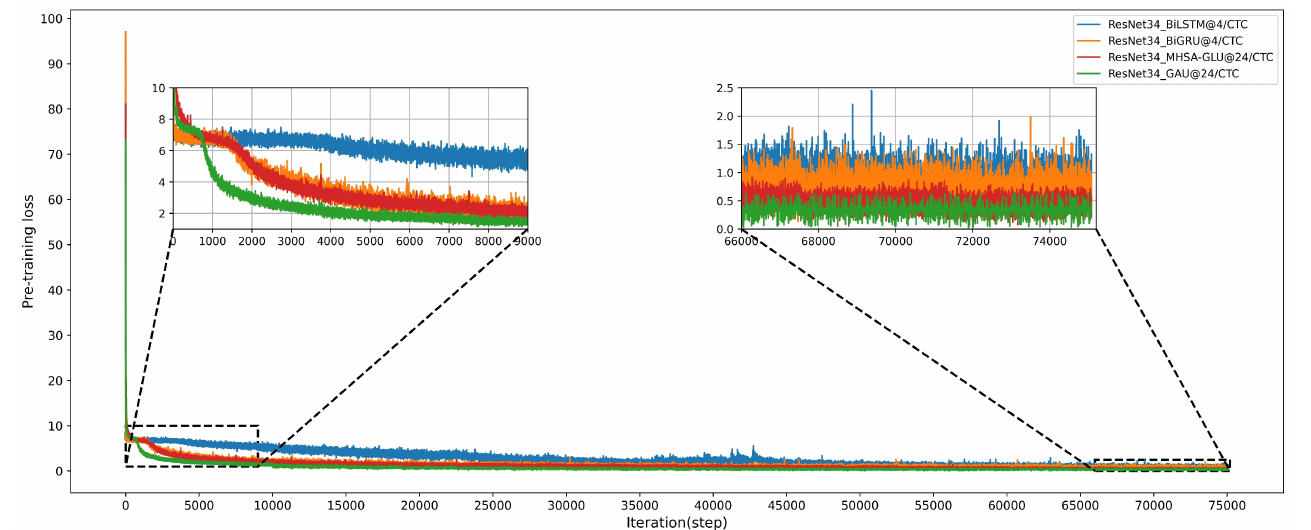
Figure 10. Pre-training loss of different